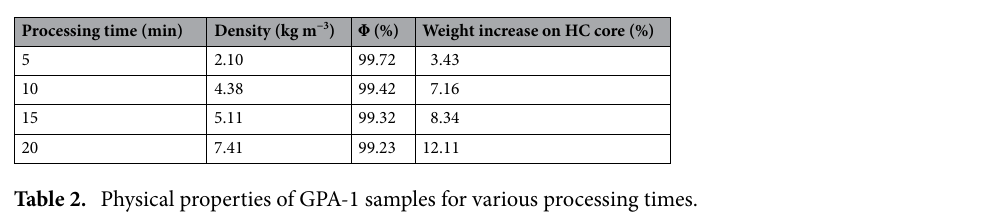
Table 2. Physical properties of GPA-1 samples for various processing times.